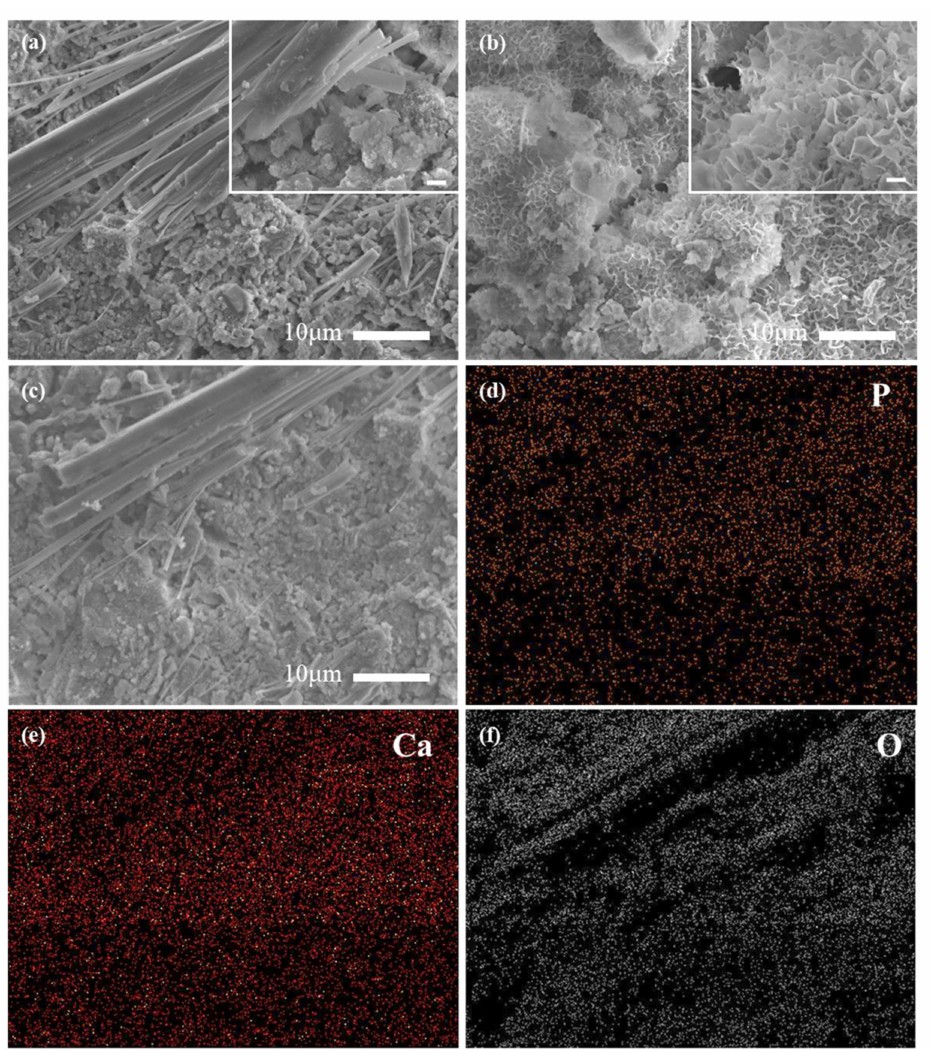
Figure 3. SEM morphologies and EDS mapping of SSD_P (10, 900): ( a – c ) show the morphologies at different sites with top right photos from a closer look at the said areas, respectively; ( d – f ) EDS mappings for P, Ca, and O elements, (marked in orange, red, and black) are